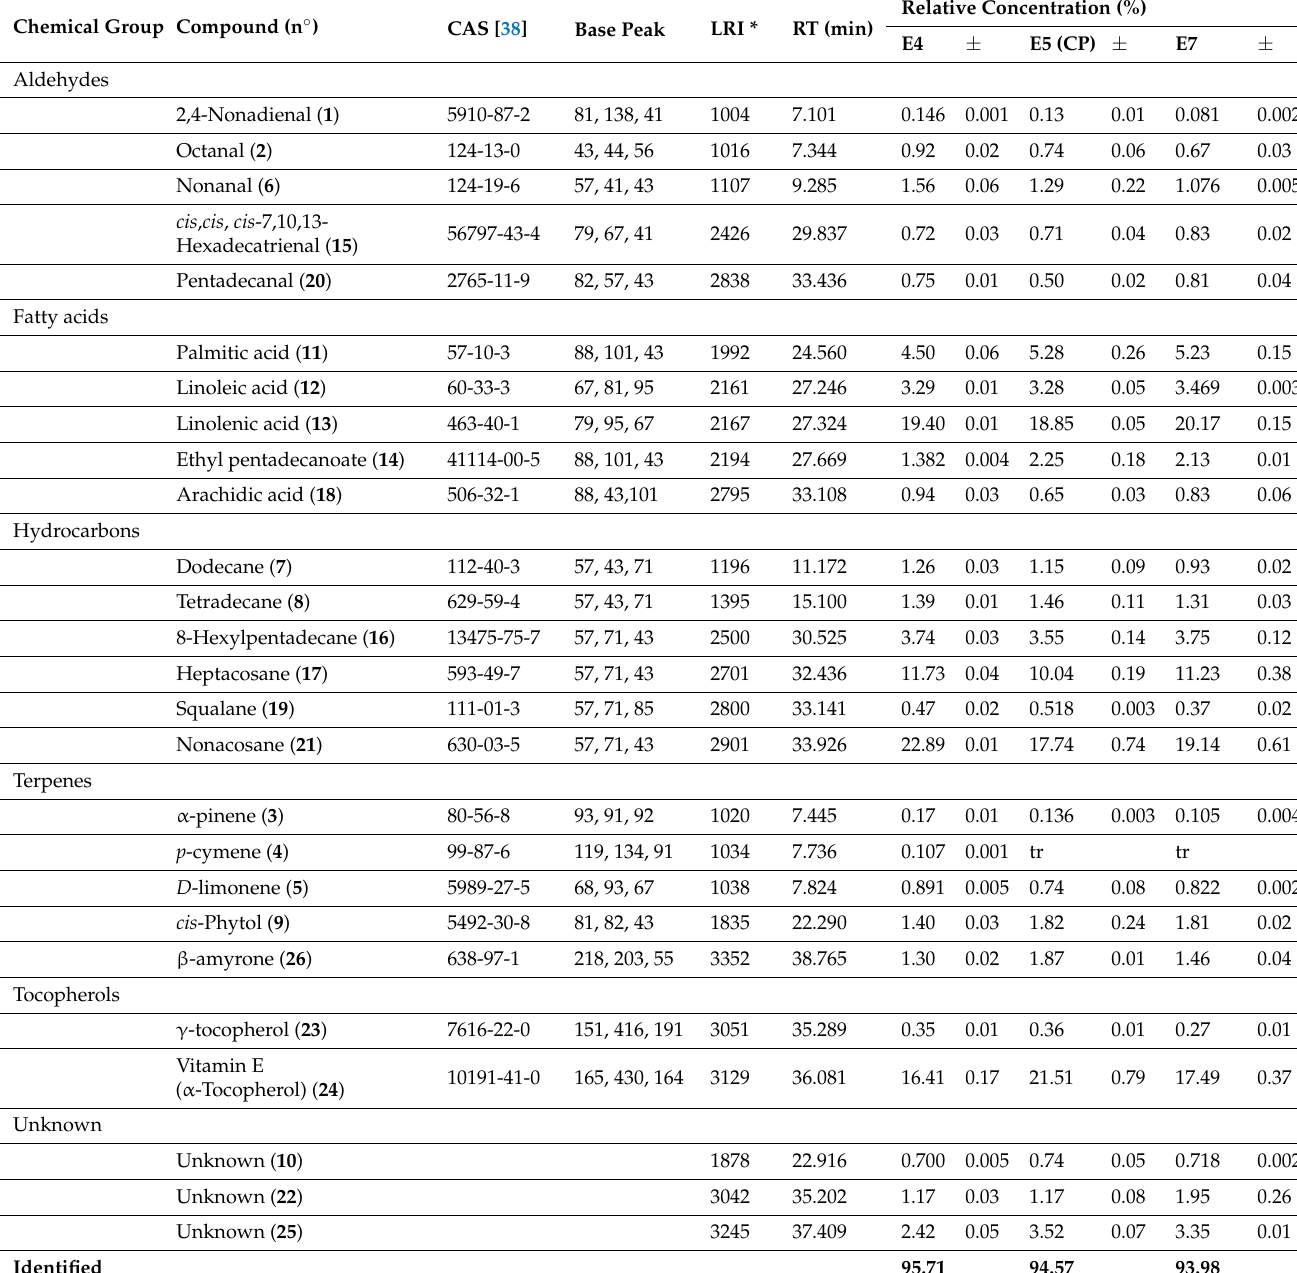
Table 4. Chemical composition of SFE-CO 2 extracts obtained from Mo leaves analysed by